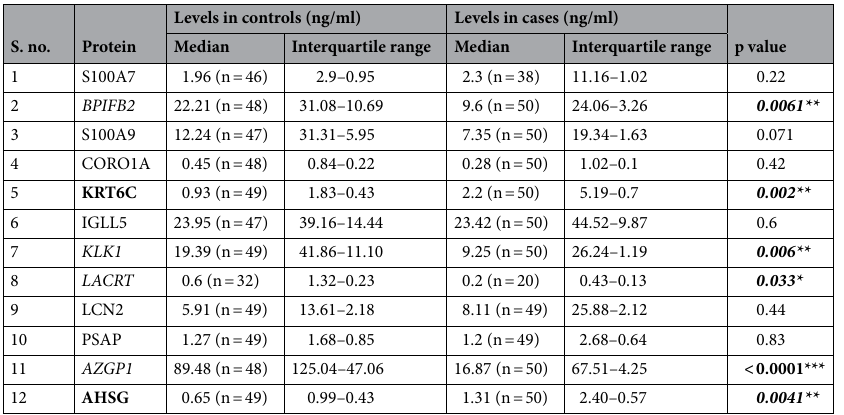
Table 1. Median levels of protein along with interquartile range as quantified using PRM. p value reported was obtained using Wilcoxon Sum Rank test. Significantly upregulated proteins are highlighted in bold and significantly downregulated proteins are highlighted in italic. Bold italics indicate statistical significance (p <